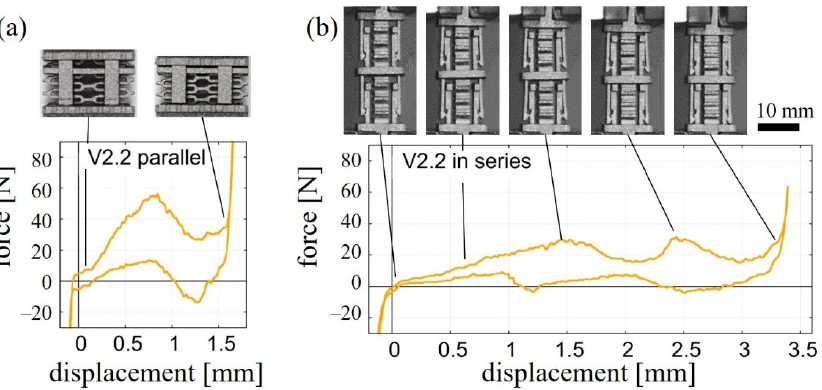
Figure 5. Force–displacement diagrams of arrangements of two V2.2 cells during cyclic compression. ( a ) Representative curve for a parallel arrangement. ( b ) Representative curve for an arrangement in series.